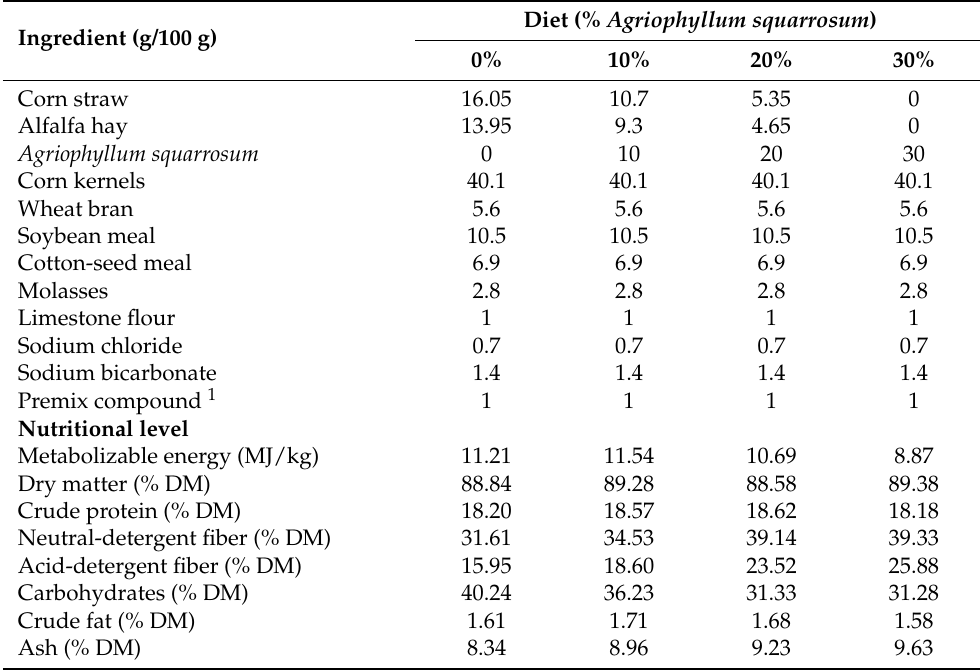
Table 1. Composition of the pellets offered the four groups of Tan lambs